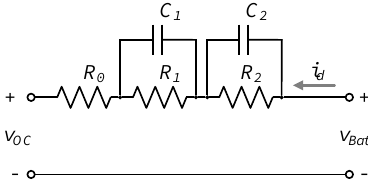
Figure 1. Equivalent electrical circuit (EEC) battery